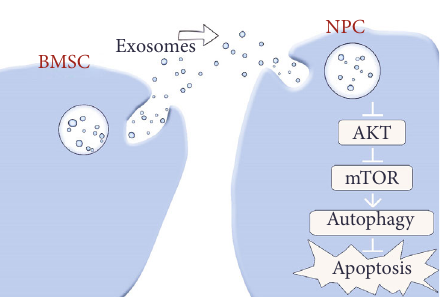
Figure 5: MSC-derived exosomes mitigate apoptosis against LPS- induced apoptosis by promoting nucleus pulposus cell autophagy, which is achieved through the Akt-mTOR signaling